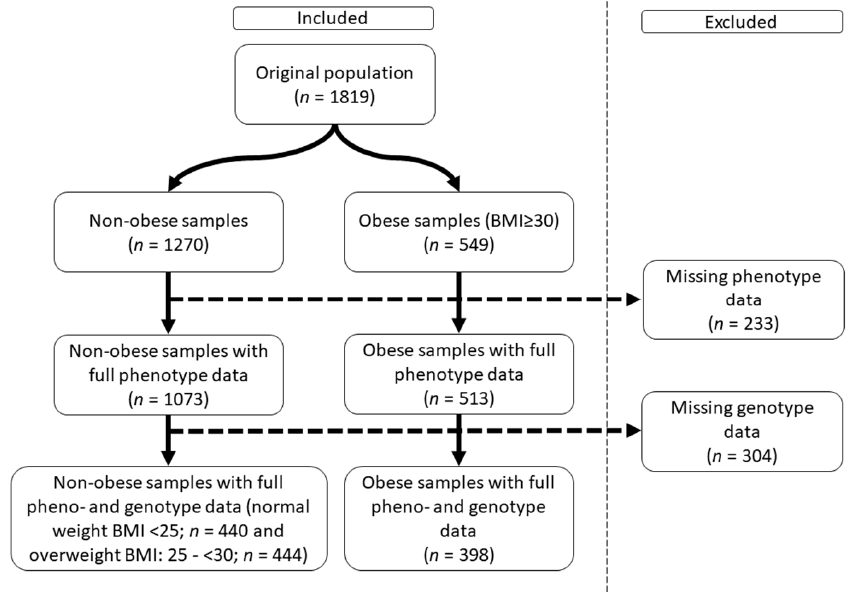
Figure 6. Flow chart of the study sample selection.